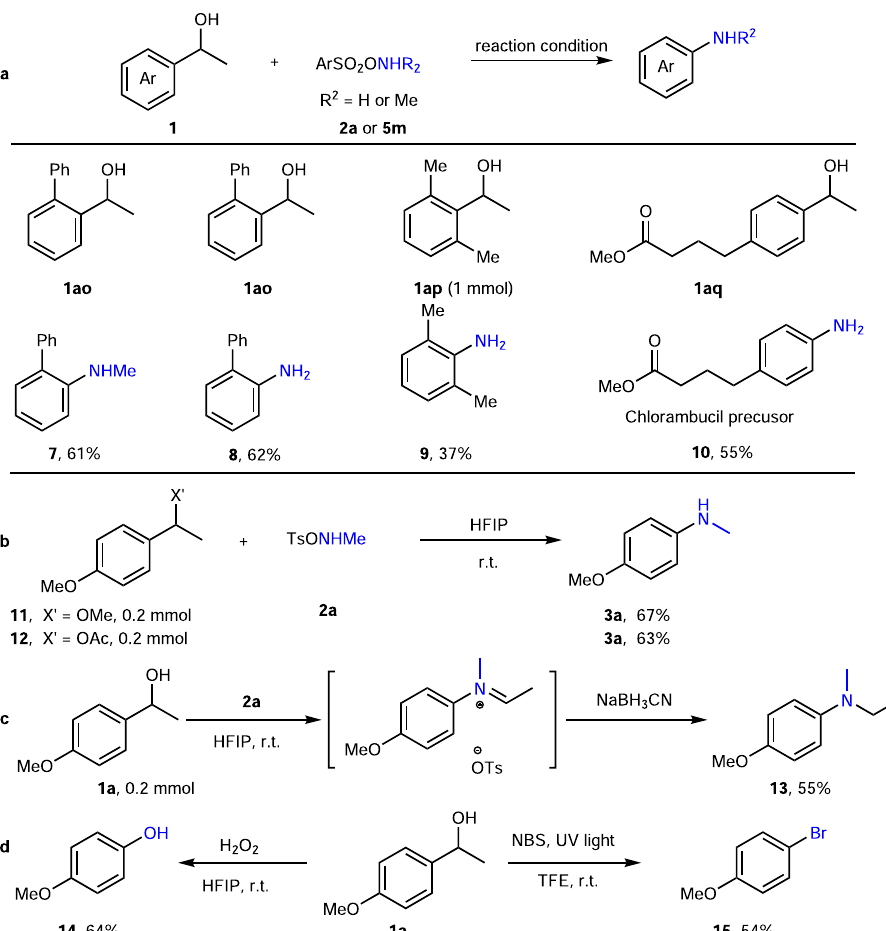
Fig. 6 Further application of our protocol. a Four aniline examples for catalysis/bioactive molecules precursors. b Benzyl ether/ester as substrate in the aza-Hock rearrangement. c Tertiary aniline synthesis with this protocol. d Phenol/aryl bromide synthesis with a similar strategy. Reaction